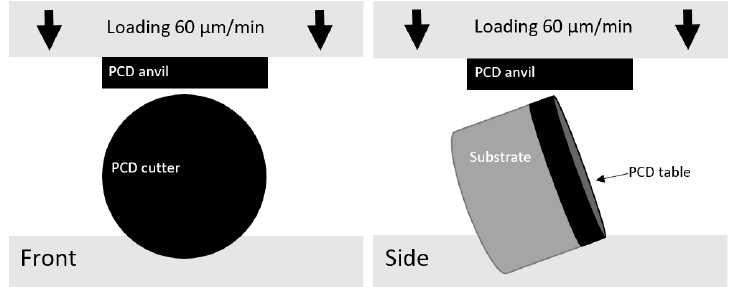
Fig. 2. Diagram of the front and side view of the quasi-static loading arrangement.